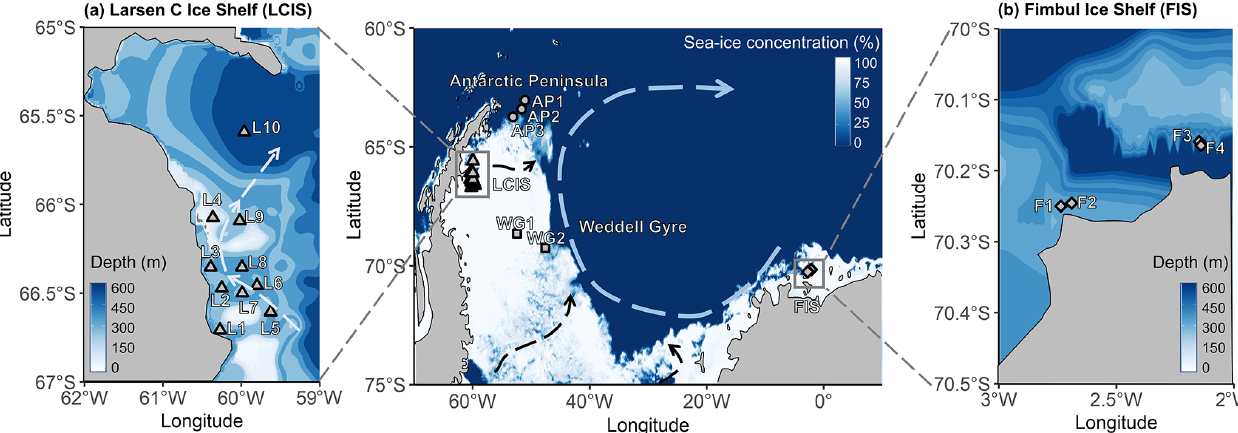
Figure 1. Maps of the Weddell Sea, Larsen C Ice Shelf (LCIS; insert a ), and Fimbul Ice Shelf (FIS; insert b ) showing the position of the stations where rate experiments were conducted during the Weddell Sea Expedition in January–February 2019. The symbols represent the different regions of the Weddell Sea sampled during the expedition (circle – Antarctic Peninsula (AP); diamond – FIS; triangle – LCIS; square – Weddell Gyre (WG)). The general cyclonic circulation of the Weddell Gyre (dashed blue arrow) is illustrated on the central map, with the dashed black arrows indicating the input of modified water masses from Filchner–Ronne Ice Shelf (FRIS) and LCIS (Gordon et al., 1993; Schröder et al., 2002; Schodlok et al., 2002). The hypothesized circulation at LCIS (Nicholls et al., 2004; Hutchinson et al., 2020) is shown by the dashed light-blue arrow in insert (a) . The 3.125km sea-ice concentration data from 31 January 2020 shown in the central panel were taken from ftp://ftp-projects.cen.uni-hamburg.de/seaice/AMSR2/3.125km (last access: 29 September 2021), and the bathymetry data (inserts a and b ) were taken from ETOPO1 (NOAA National Geophysical Data Center, 2009).